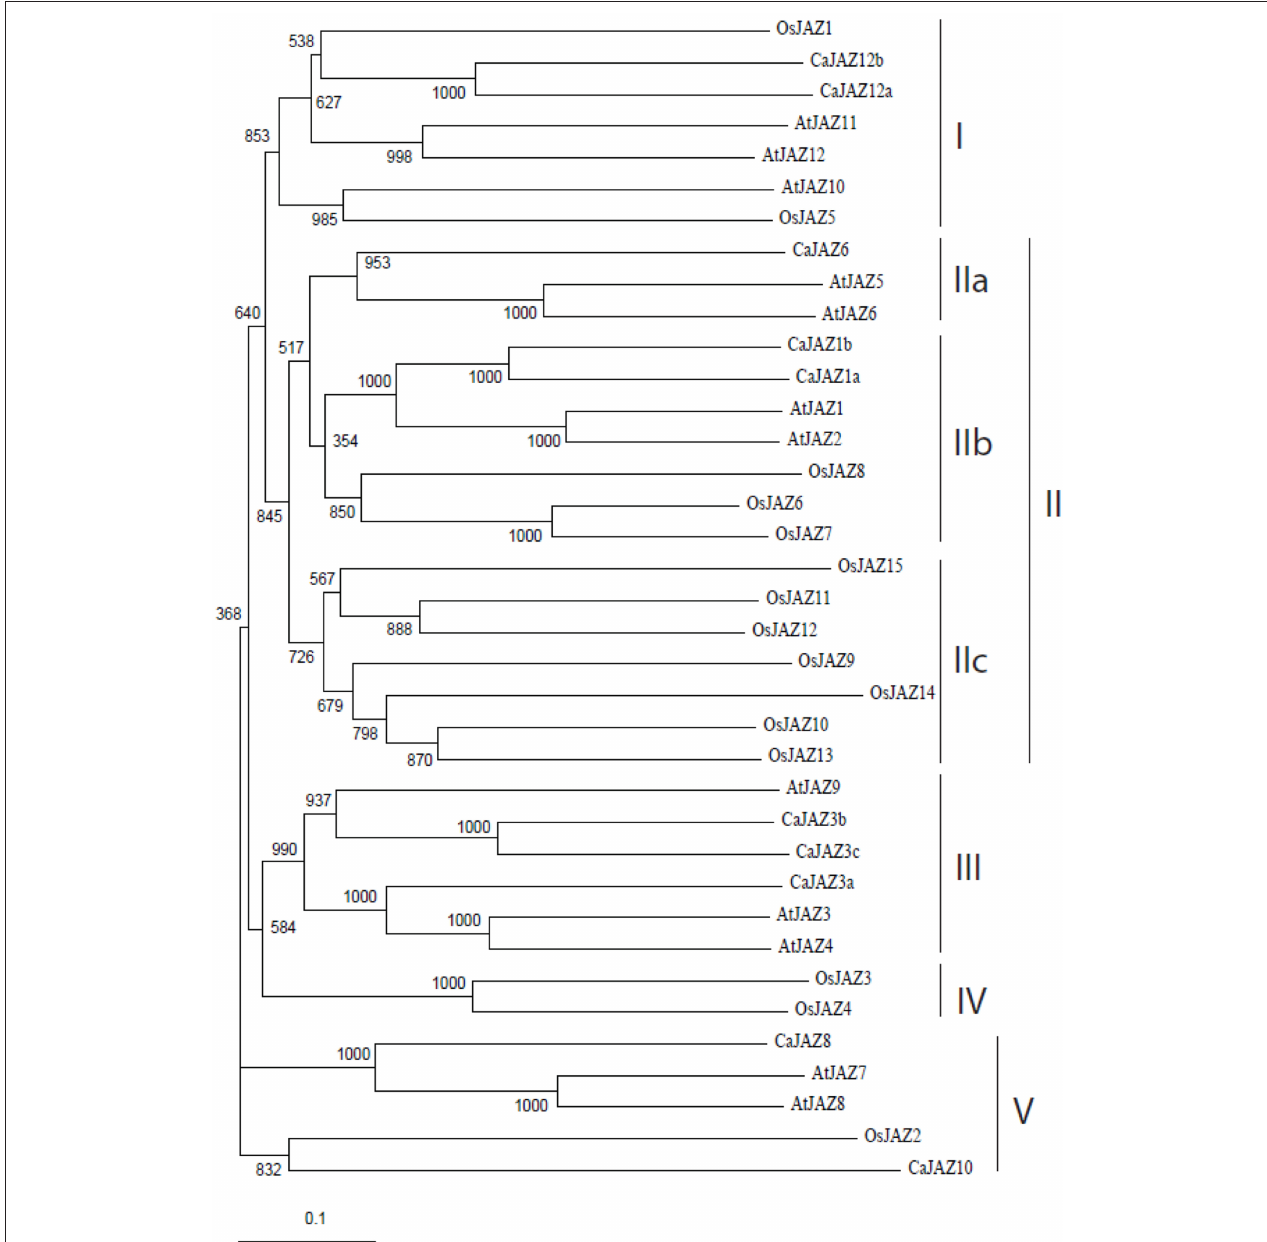
FIGURE 1 | Unrooted phylogenetic tree of rice, chickpea, and Arabidopsis JAZ proteins. Amino acid sequences of JAZ proteins were aligned in Clustal X and phylogenetic tree was constructed using NJ method. Scale bar represents amino acid substitution rate, bootstrap values are mentioned at each node.